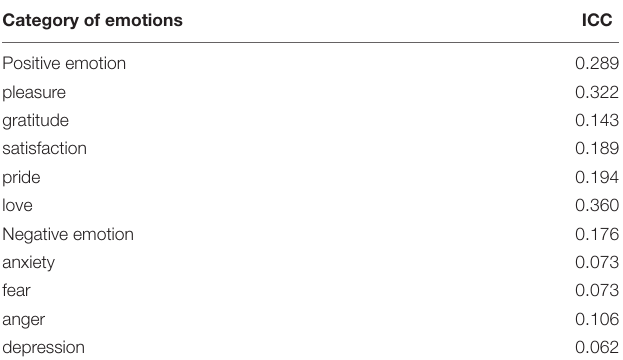
TABLE 2 | ICC in the null model for